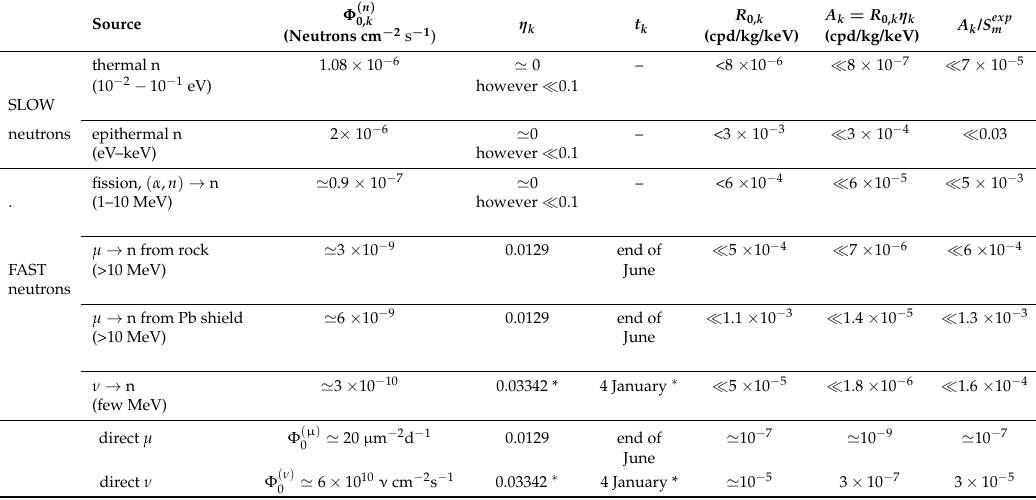
Table 2. Contributions to the total neutron flux at Laboratori Nazionali del Gran Sasso (LNGS); the ( n ) value, Φ , the relative modulation amplitude, η k , and the phase, t k , of each component are reported. 0, k It is also reported the counting rate, R 0, k , in DAMA/LIBRA–phase2 for single-hit events, in the (1 − 6) keV energy region induced by neutrons, muons and solar neutrinos, detailed for each component. The modulation amplitudes, A k , are reported as well, while the last column shows the relative contribution to the annual modulation amplitude observed by DAMA/LIBRA–phase2, S exp m (cid:39) 0.011 cpd/kg/keV. For details, see Ref. [31] and references